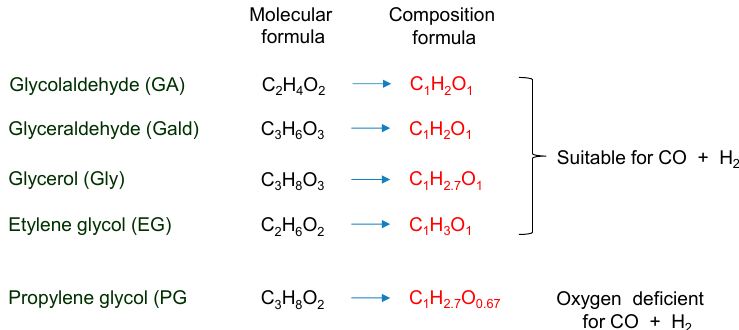
Figure 4. Production of syngas (CO + H 2 ) from glyceraldehyde, 1,3-dihydroxyacetone, glycerol, ethylene glycol, and propylene glycol as discussed with the composition formula.